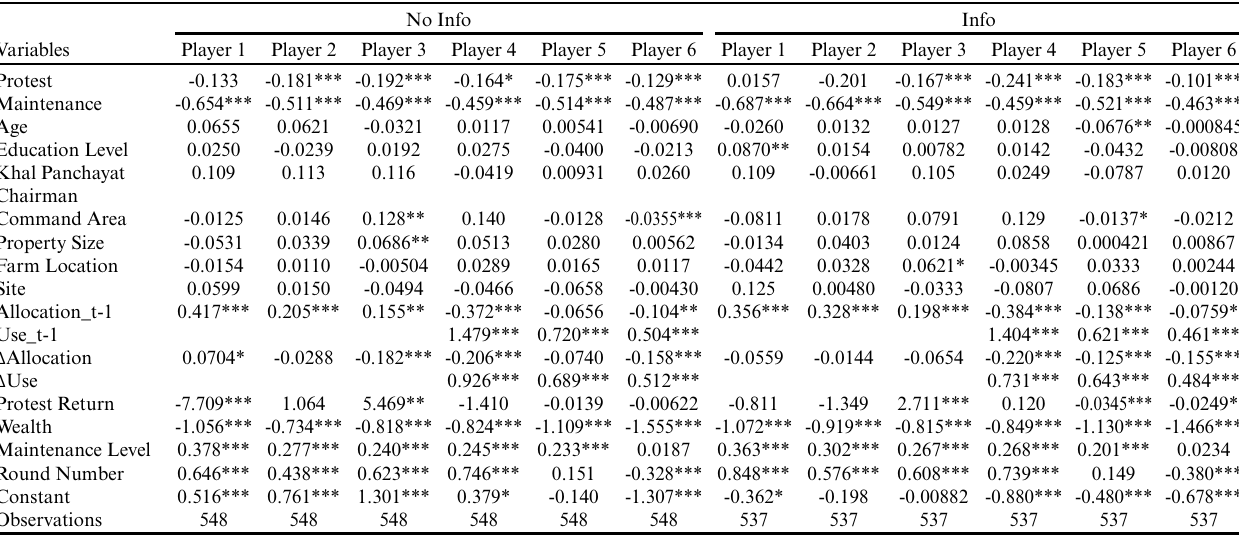
Table 5 . Player-by-player regressions: lobby